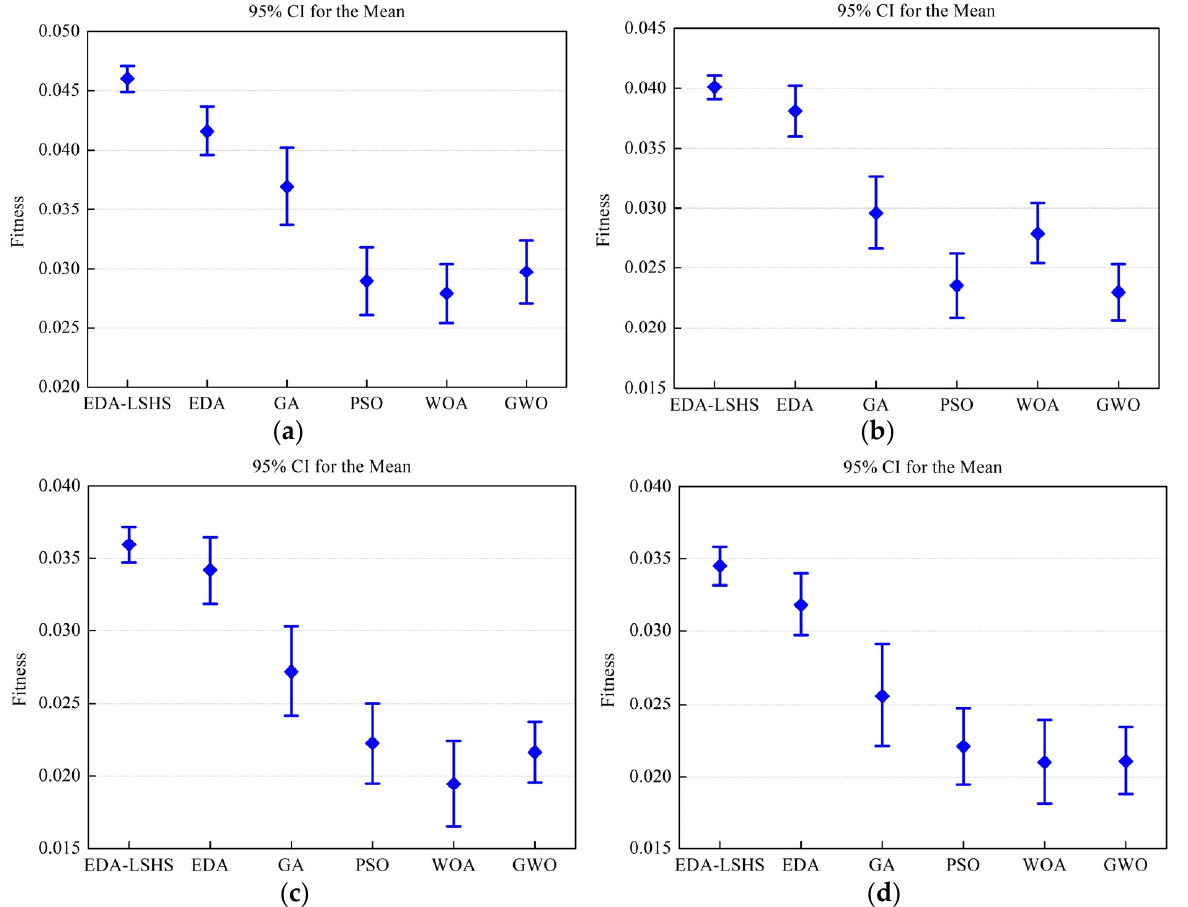
Figure 8. The error analysis of the compared algorithms. ( a ) Product 1; ( b ) Product 2; ( c ) Product 3; ( d ) Product 4.